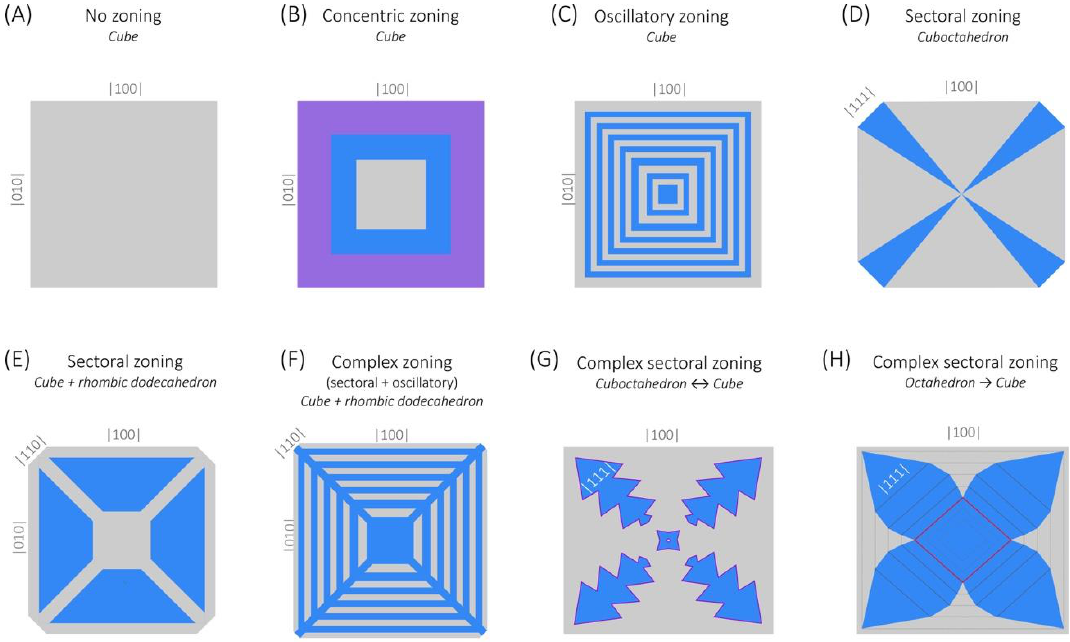
Figure 7. Various examples of growth zoning features typically found in hydrothermal fluorites as evident from the petrography and cathodoluminescence and BSE imaging (Figures 2 and 3). Different colours illustrate image contrasts, and thus, differences in chemical composition (corresponding to fluorite generation I and II). Plane section for ( D , G , H ) is |110|, all other examples are shown parallel to |001|. No apparent zoning ( A ) suggests crystallization under constant hydrothermal conditions, whereas concentric zoning ( B ) indicates discontinuous changes in the fluid chemistry over time; ( C ) is a typical representation of short-lived oscillating changes in the fluid chemistry. ( D , E ) Typical sectoral zoning in fluorite crystals with complex crystal habits (( D ): cuboctahedral, ( E ): cubic + rhombic dodecahedral faces) that is only visible in specific plane sections. ( F ) Combination of sectoral and oscillatory zoning in a cubic fluorite crystal. ( G ) ‘Fir-tree’ zoning occurs when growth conditions (T/Eh) alternate over time and thereby favour different crystal morphologies (cuboctahedron ↔ cube), which proves pulsed crystallization (e.g., [106]). ( H ) ‘Petal-type’ zoning is the result of a continuous change from octahedral growth to cubic growth; the red line marks the beginning of shape transition (modified from [104]). Image ( B , E ) correspond to features visible in Figure 3B (parallel to |111|) and Figure 3C (parallel to |100|); image ( F ) resembles zoning details visible in Figure 3F, while image ( G ) is similar to growth patterns apparent in Figure 3E in the area labelled